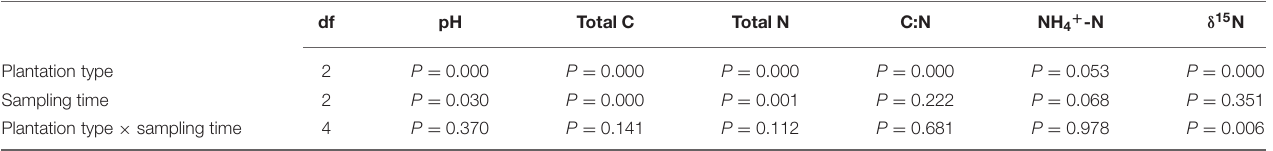
TABLE 1 | P -values obtained from a two-way analysis of variance (ANOVA) to detect the effects of plantation type, sampling time, and their interaction on the measured soil variables at Kolombangara, Solomon Islands. df pH Total C Total N